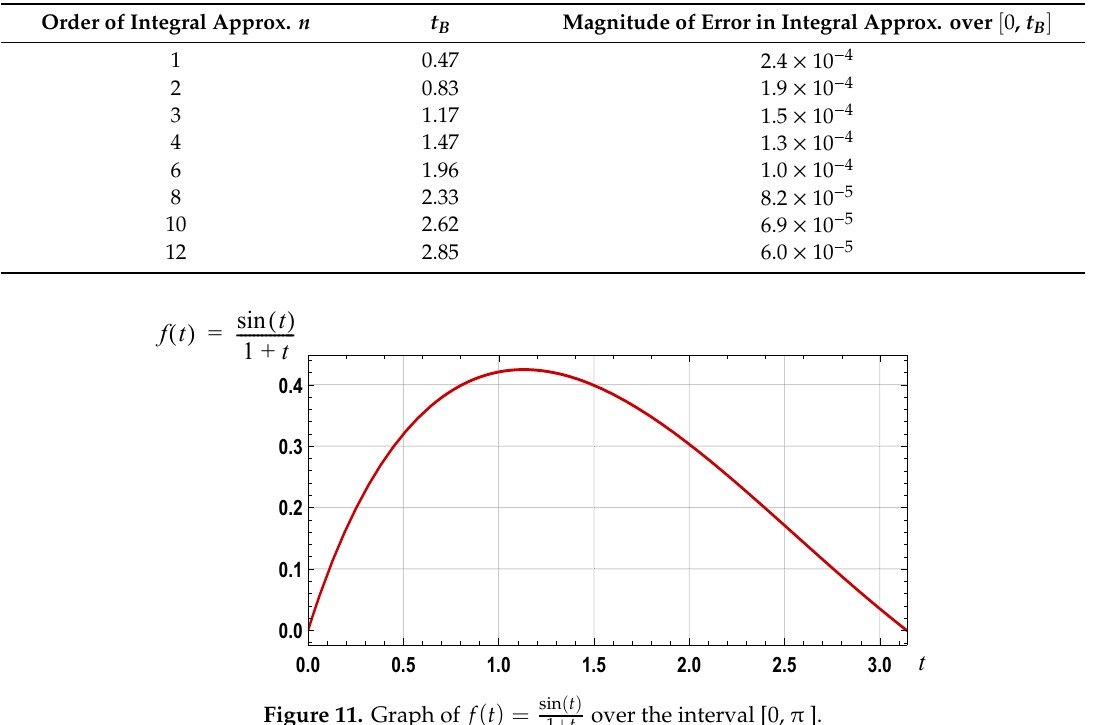
( t ) = sin ( t ) over the interval [0, π Figure 11. Graph of Figure 11. Graph of f 1 + t Table 1. Interval of integration for a spline based approximation and for a specified error